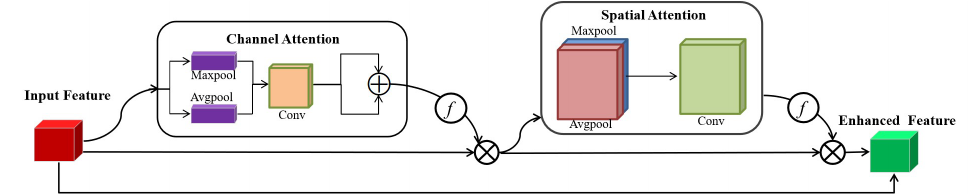
Figure 3. The illustration of the channel and spatial dual attention